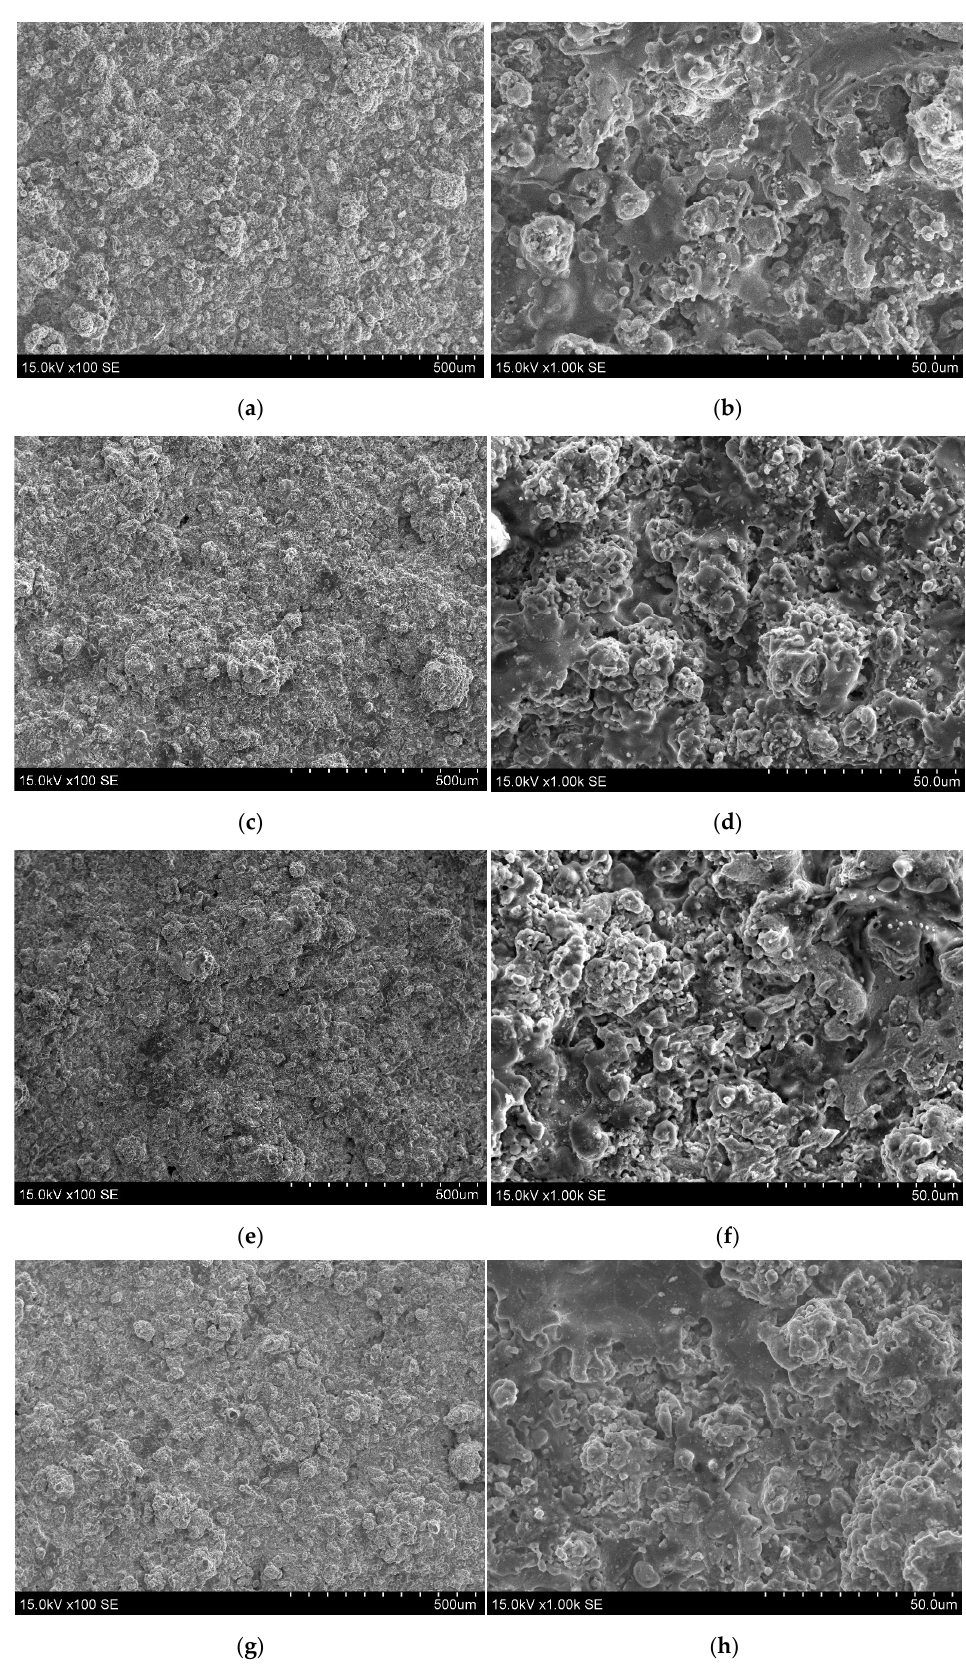
Figure 9. SEM micrographs of Al 2 O 3 -13 wt.% TiO 2 coating, before ( a , b ) and after ( c , d ) 5, ( e , f ) 15, and ( g , h ) 25 heat treatment cycles.